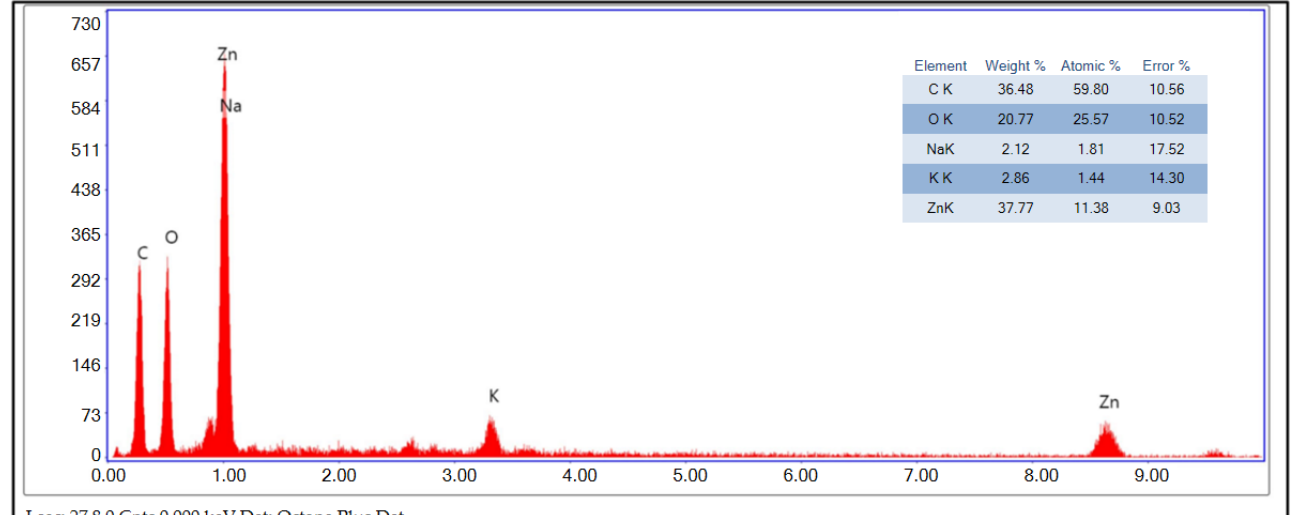
Figure 3. EDX spectrum of synthesized Zinc oxide nanoparticles.